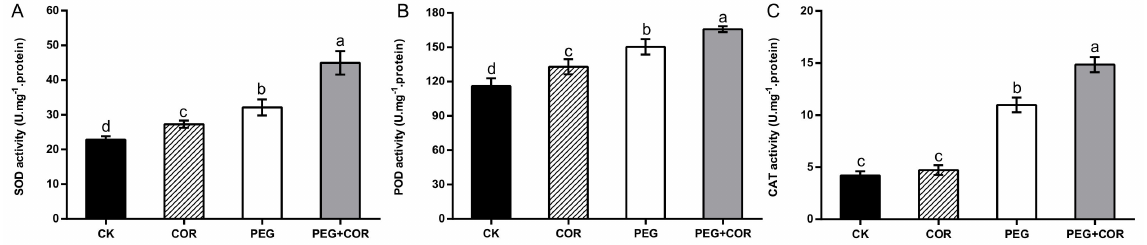
Figure 3. Activities of SOD ( A ), POD ( B ), CAT ( C ) in leaves of maize seedlings under 10% PEG treatment. CK and COR indicated the well-watered plants and well-watered plants treated with COR, respectively. PEG and PEG+COR indicate the water-stressed plants and water-stressed plants in presence of COR, respectively. Values are the mean ± SD ( n = 3), and different letters indicate significant differences ( p < 0.05) among the